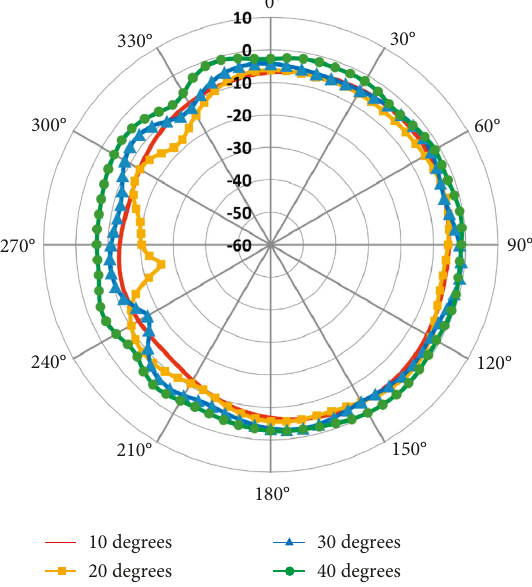
Figure 18: Measured GNSS radiation pattern for 4 different ele- vation angles at 1575MHz on a ground plane.